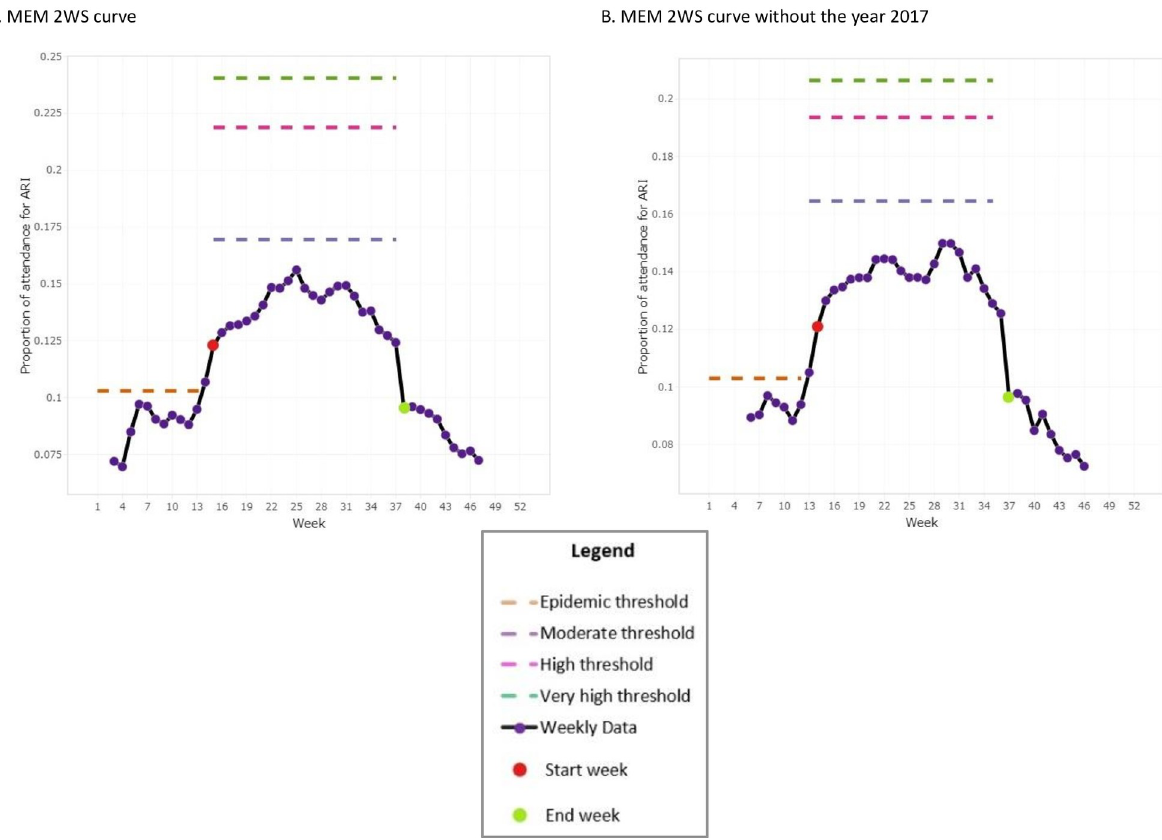
Fig 1. Comparative analysis for the two wave/season curve of the proportion of attendance for ARI in Mauritius using MEM.